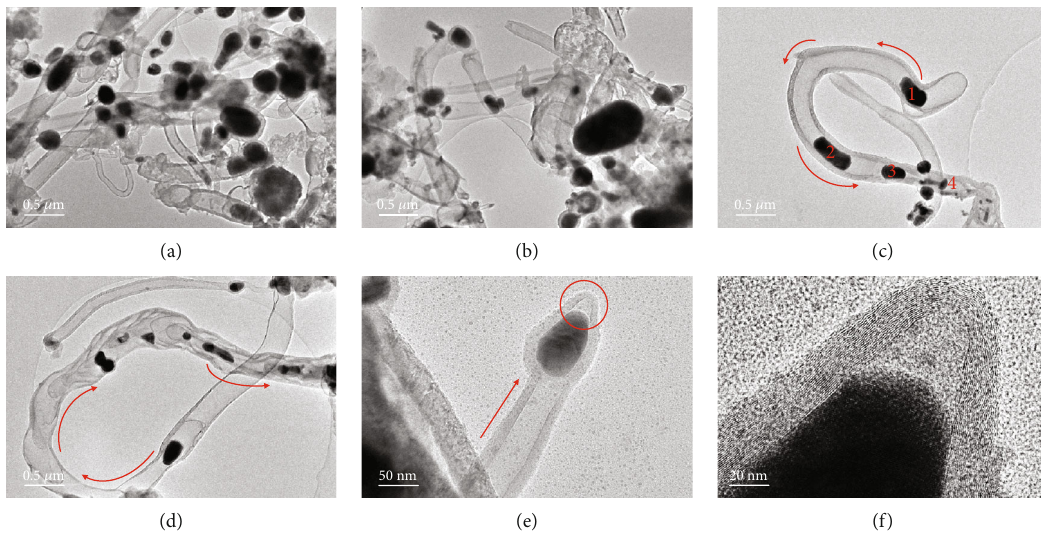
Figure 2: (a, b) TEM images of the CNTs synthesized by 30 s microwave time and protruded catalyst Fe NPs are observed to direct the CNT growth. (c, d) TEM images showing the cascade growth process of the CNTs; the catalyst Fe NPs are protruded towards the growth direction and lifted to direct the growth from the parent NP, forming a discontinuous cascade of NPs. The growth direction is marked with red arrows. (e) TEM image showing a CNT as the growth process is terminated. A catalyst Fe NP encapsulated in carbon shells can be observed at the tip of the CNT. The carbon shells are composed of orderly stacking graphene layers as shown in